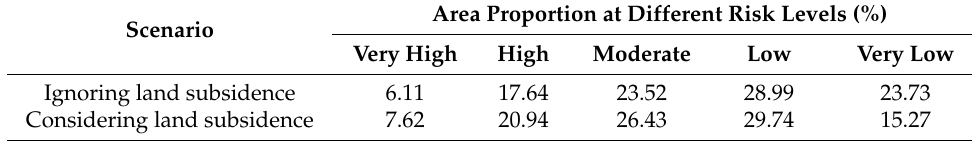
Figure 16. The area distribution of different flood risk levels in the subway system. Table 6. Area proportion of each risk level in different